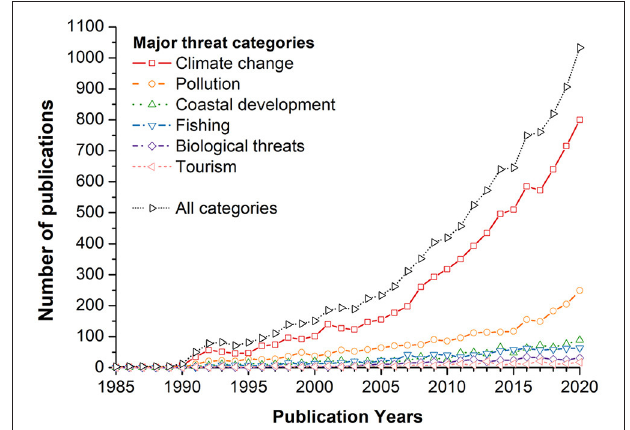
FIGURE 1 | Time series of publications registered in Web of Science Core Collection, including in the title or abstract or keywords at least one the following habitat descriptors: “biogenic reef*” or bioconstruction* or bioherm* or “coral reef*” or “Sabellaria reef*” or “sabellariid reef*” or “serpulid reef*”